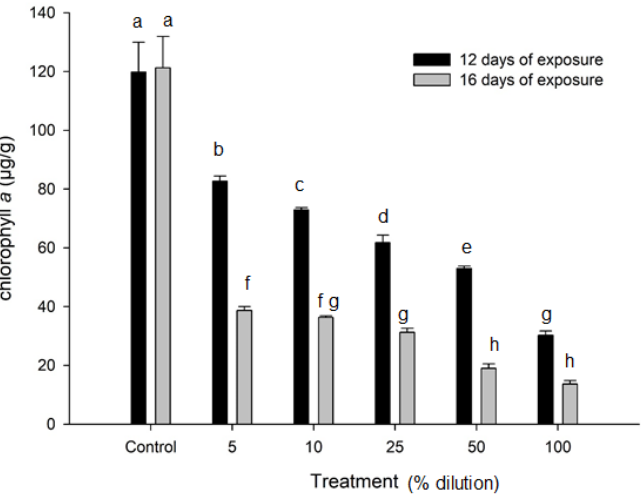
Figure 5. The average concentration of chlorophyll a from Rhizophora mangle seedlings between treatments and exposure times. The error bars represent the standard deviation. Treatments that do not share a letter are significantly different ( p ≤ 0.05).